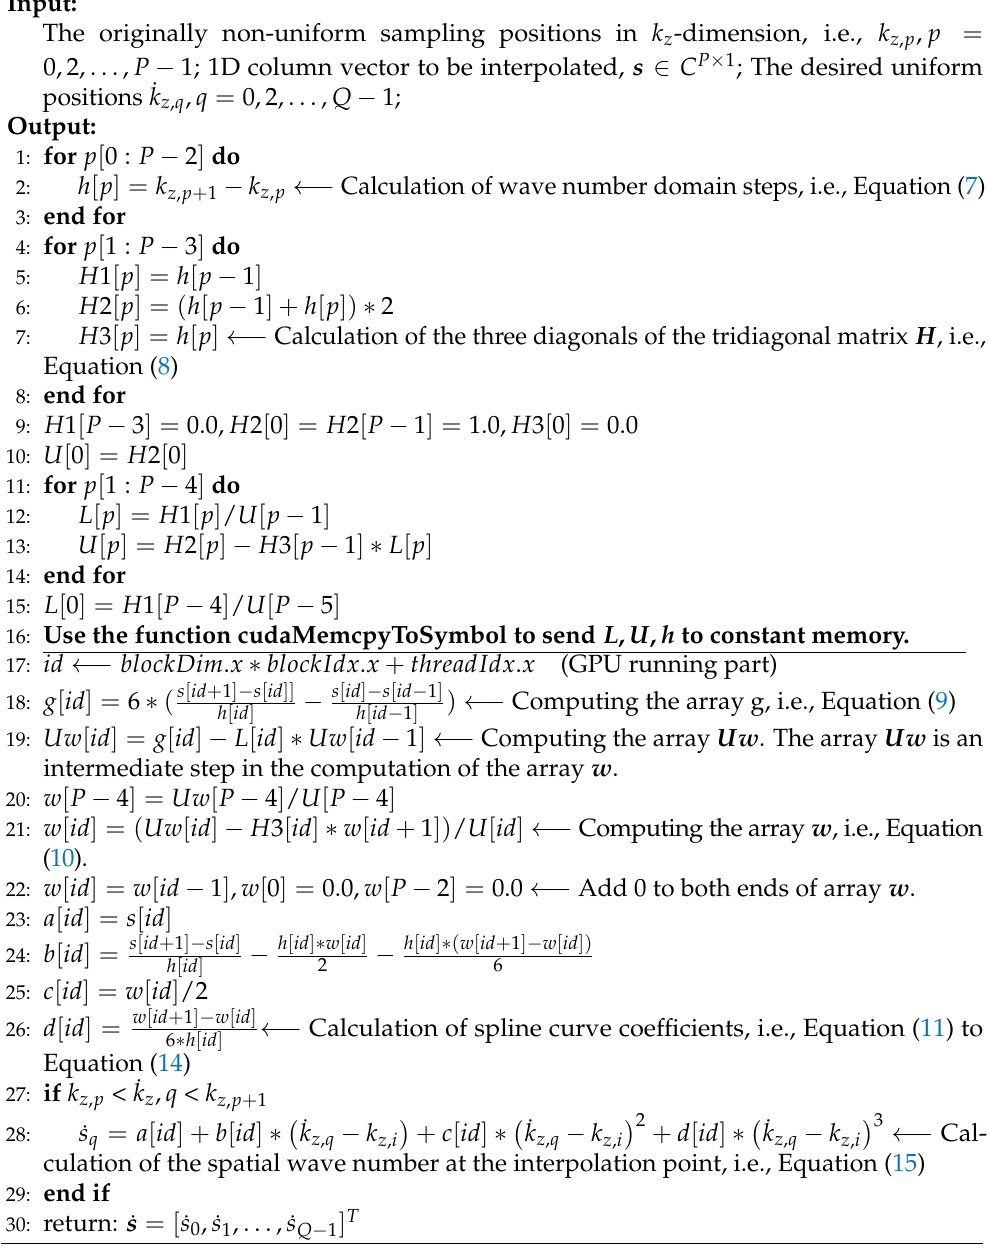
Algorithm 3 Hybrid CPU-GPU method pseudo code of cubic spline